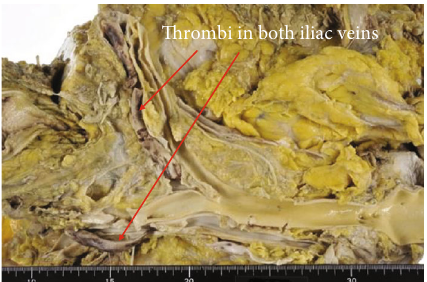
Figure 3: Pulmonary embolism at the hilar portion of (a) lung. (b) is an enlarged image of a pulmonary embolism (x20).